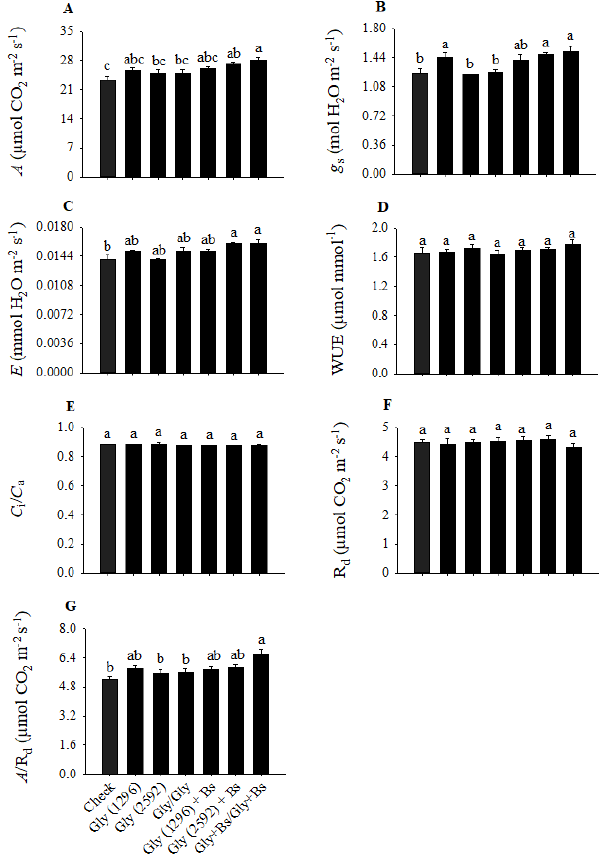
Figure 2. Gas exchange parameters in plants submitted to different doses of glyphosate, with or without application of B. subtilis BV02. The following parameters were evaluated: rate of net carbon assimilation ( A -( A )), stomatal conductance (g s -( B )), transpiration ( E -( C )), water use efficiency (WUE-( D )), the ratio between internal and the external concentration of CO 2 (C i /C a -( E )), nocturnal respiration (Rd-( F )), and the ratio between photosynthetic rate and respiration (A/Rd-( G )). Means followed by the same lowercase letters do not differ according to the SNK test ( p ≤ 0.05).